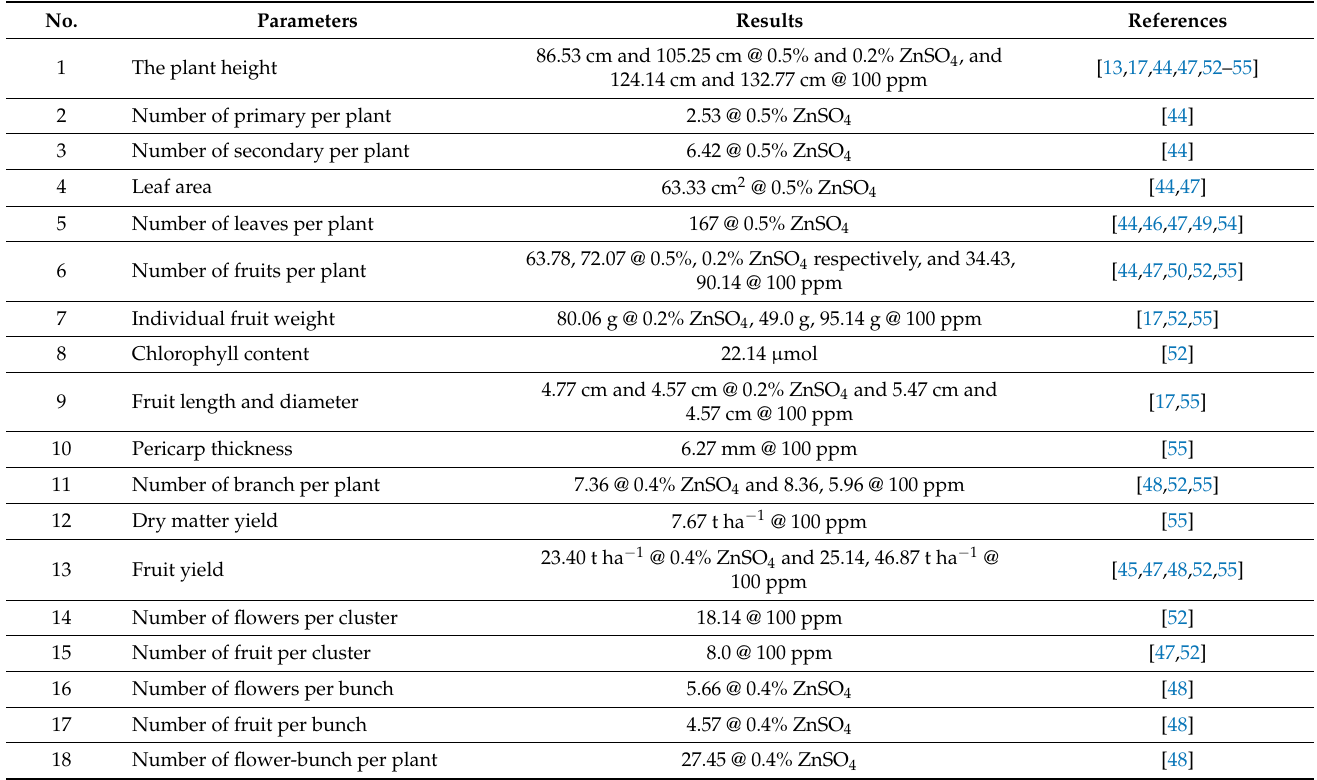
Table 1. Influence of Zn on different